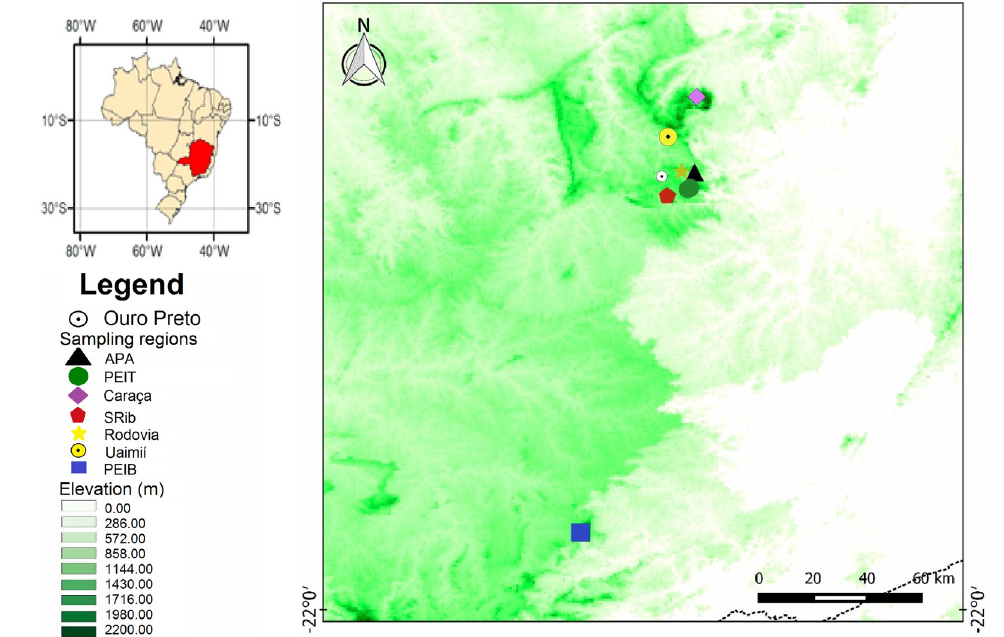
Fig 1 . Map showing sampling regions in the state of Minas Gerais, Brazil.